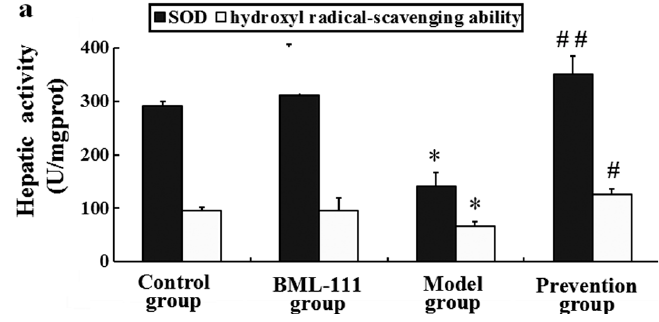
Figure 8. Cont. Figure 8.